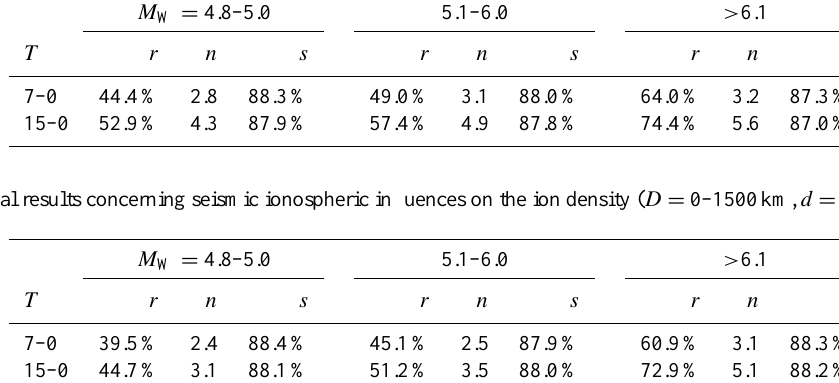
Table 6. The statistical results concerning seismic ionospheric influences on the ion density ( D = 0–1500km, d = 0–20km). M W = 4.8–5.0